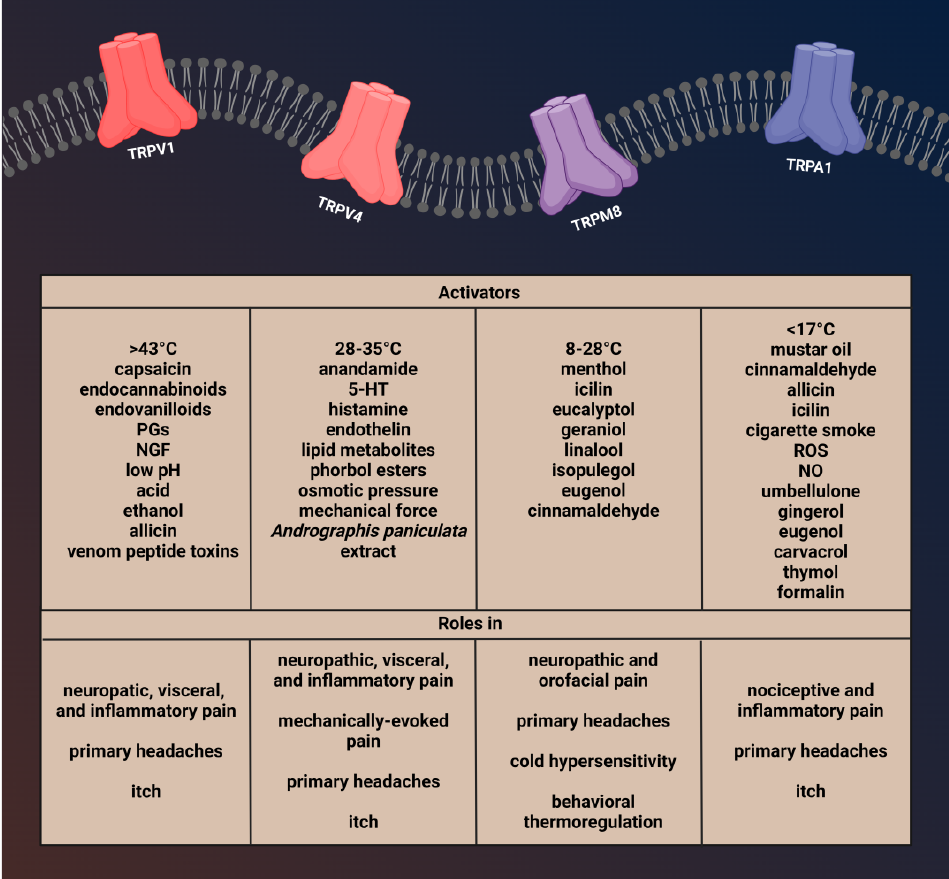
Figure 2. Activators and function of transient receptor potential channels involved in migraine.